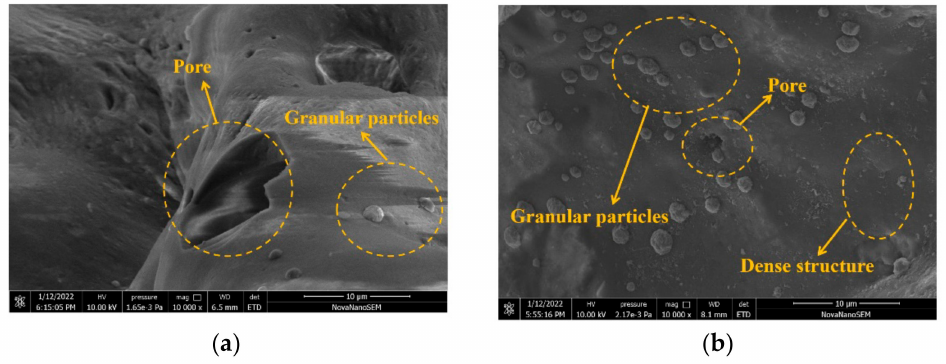
Figure 12. SEM micrographs of clay ceramsite and sludge ceramsite. ( a ) Clay ceramsite. ( b ) Sludge